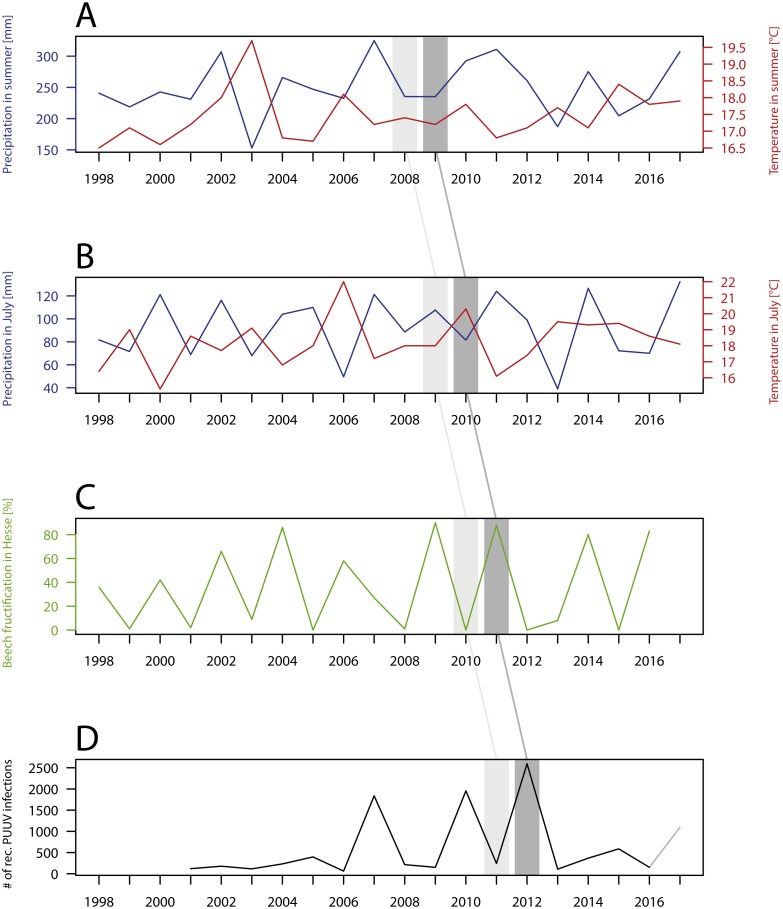
Temporal patterns of the number of recorded PUUV infections and related factors.(A) Precipitation and temperature in summer (i.e., June, July and August); (B) Precipitation and temperature in July; (C) Percentage of old beech trees with medium or strong fructification in Hesse, Germany; (D) Number of recorded PUUV infections between 2001 to 2016 (2017, data as from 14.11.2017) in Germany. Note the different time lags (also described in Material and Methods). The figure based on data provided by the Robert Koch Institute, the GeoBasis-DE/BKI, the Deutscher Wetterdienst, the Hessisches Ministerium für Umwelt, Klimaschutz, Landwirtschaft und Verbraucherschutz, and was built using R 3.4.2 (R Core Team, 2016).